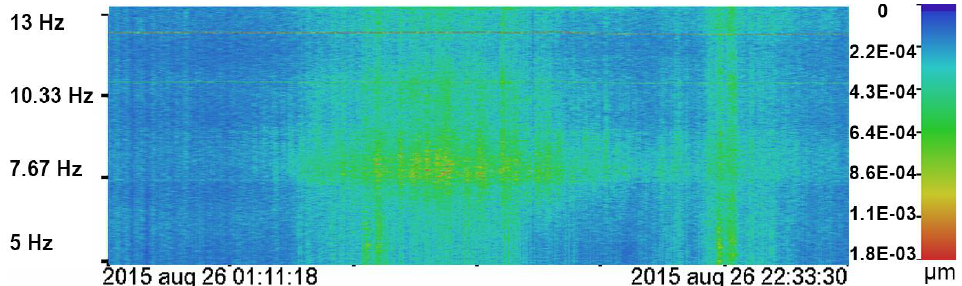
Figure 14. Dynamic spectrogram of laser strainmeter data during influence of Goni